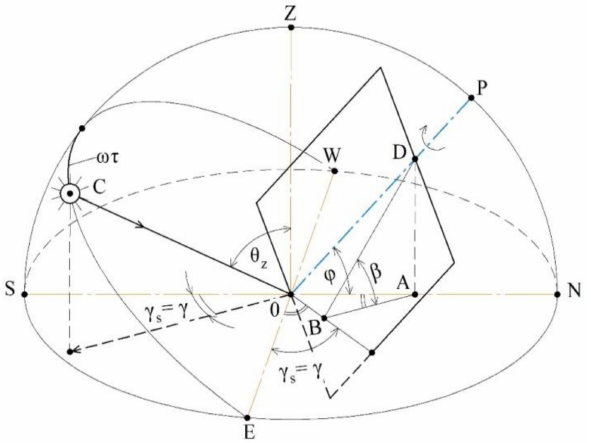
Figure 13. Scheme of irradiation of the tracking surface of a polar-rotating tracker in the period of equinox—designed based on